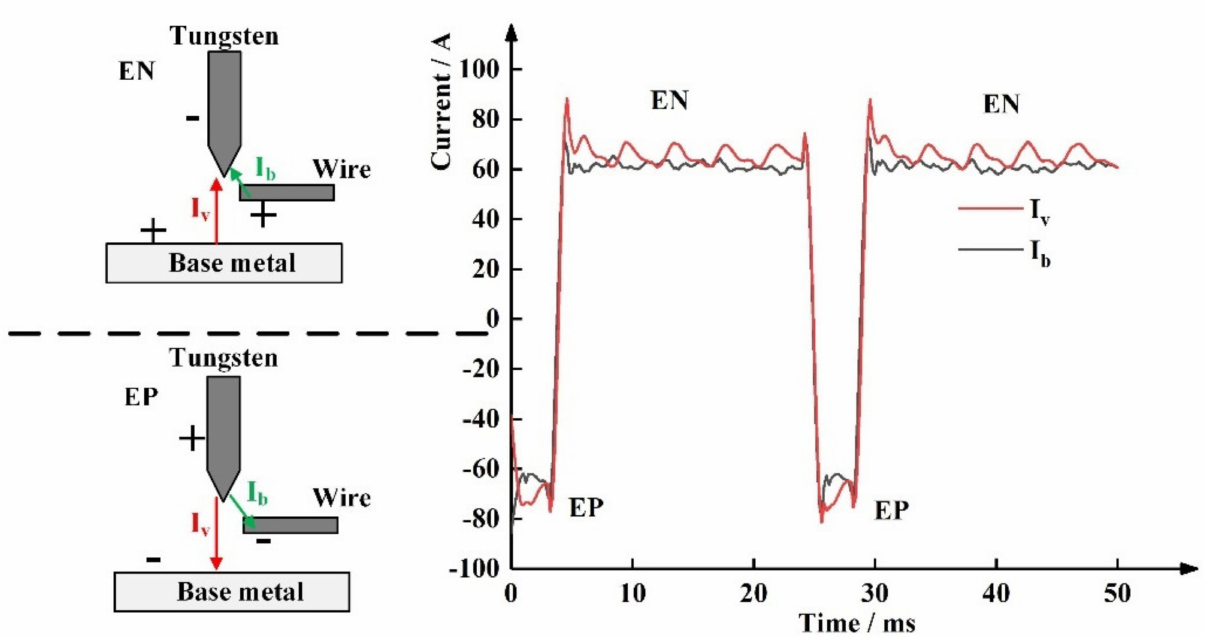
Figure 2. Current waveform diagram.